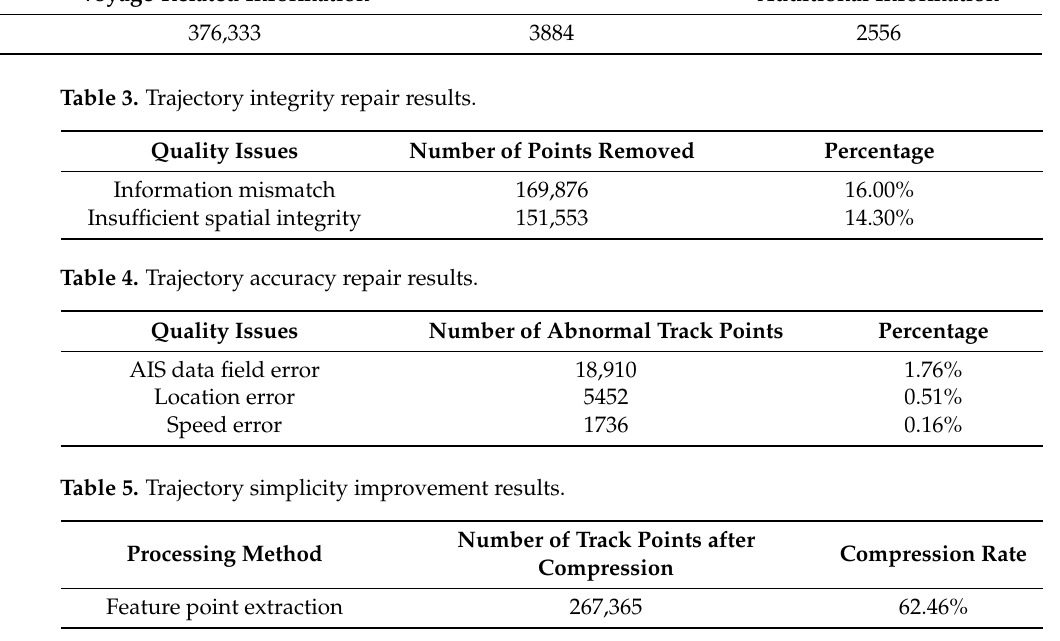
Table 2. The size of raw data in the research area.